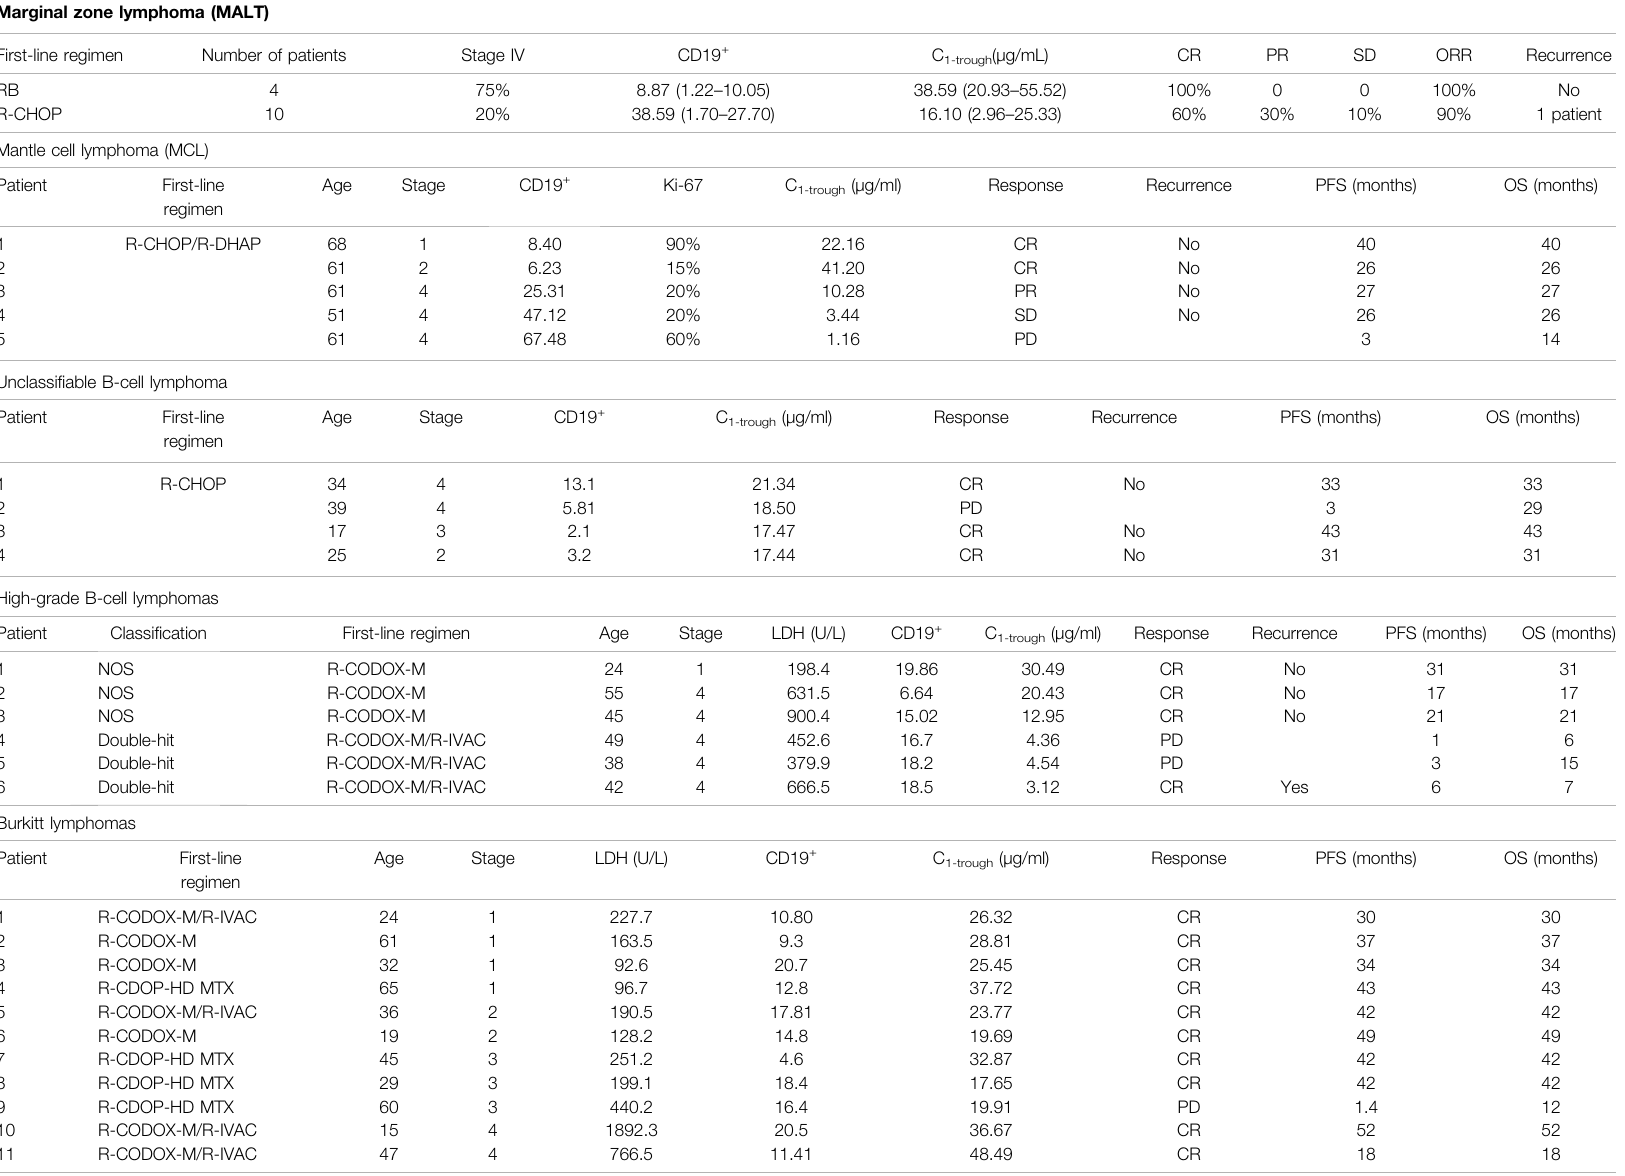
TABLE 3 | Rituximab concentrations, baseline characteristics and clinical outcomes of marginal zone lymphoma patients, mantle cell lymphoma patients, unclassi fi able B-cell lymphoma (intermediate between DLBCL and classical Hodgkin ’ s) patients, high-grade B-cell lymphoma patients, Burkitt lymphoma patients and mixed B-cell lymphoma patients. Marginal zone lymphoma